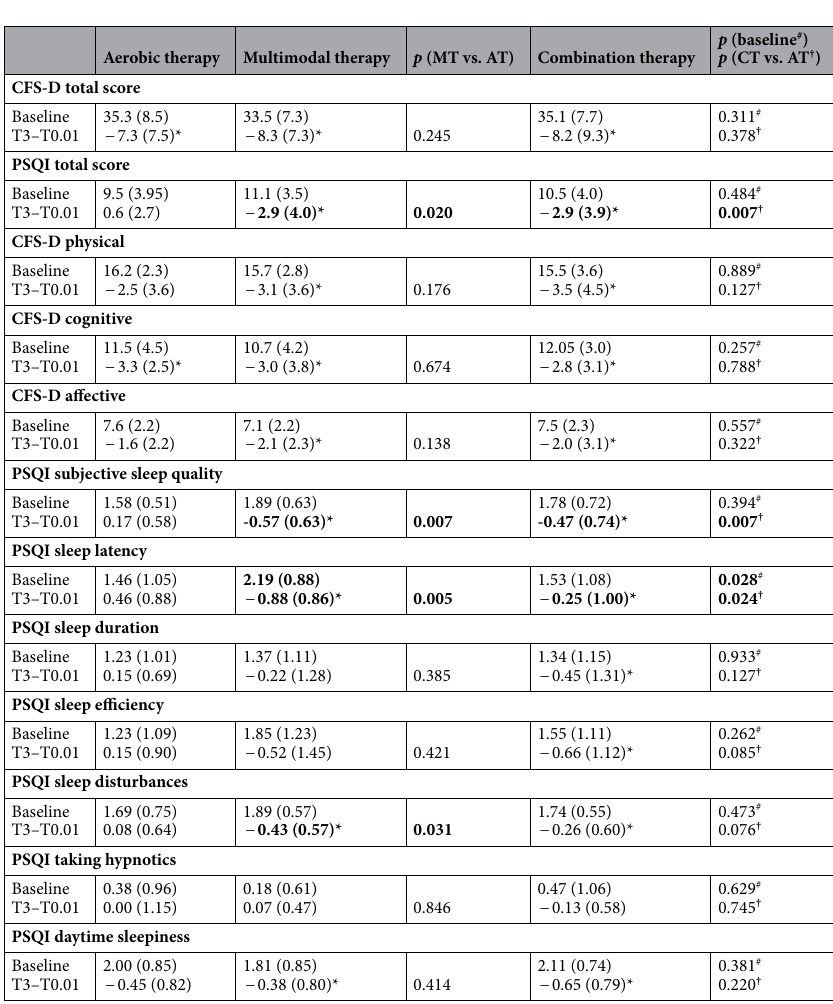
Table 3. CFS-D and PSQI baseline data and T3–T0 differences (with standard deviation), n = 79. # Differences between the 3 groups at baseline are tested with the van Elteren test (see baseline row, last column). *Significant changes from Baseline to T3; significant differences between MT and AT (see T3–T0.01 row, third column) or CT and AT (see T3-T0.01 row, last column) are presented in bold. The p value CT versus AT is specified with † . AT Aerobic therapy, MT multimodal therapy, CT combination therapy, CFS-D cancer fatigue scale, German version, PSQI Pittsburgh Sleep Quality